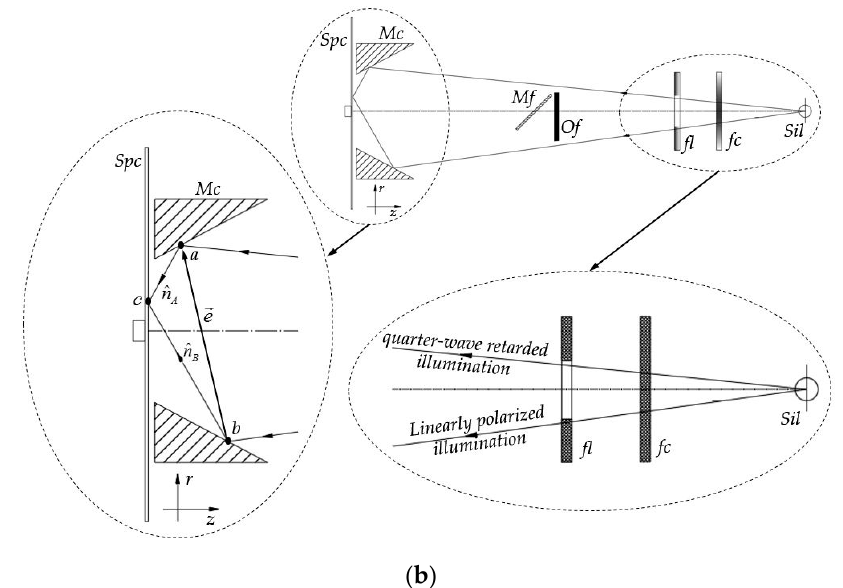
Figure 1. ( a ) The proposed optical arrangement for ESPI interferometry with radial-in-plane sensitivity and divergent illumination. ( b ) The scheme of optical arrangement, where SiL is the source of the illumination laser; fc , one-quarter wave retarder film; fl , linear polarizer; Of , opaque filter; Mf , flat mirror; Mc , conical mirror; Spc , surface specimen; 𝑒⃗ is the sensitivity vector; and 𝑛(cid:3548) (cid:3002) and 𝑛(cid:3548) (cid:3003) are unitary vectors related to the illumination beams.